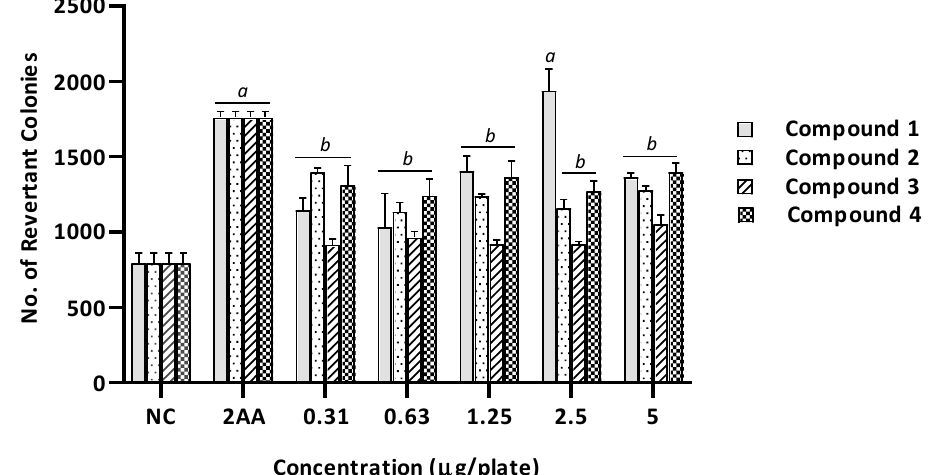
Figure 4. The number of revertant colonies of TA98 strain of Salmonella typhimurium treated with di ff erent concentration of benzimidazole derivatives (1–4) in the presence of metabolic activation system ( + S9). NC, Negative control (1% of DMSO in PBS); 2AA (2-aminoanthracene), Positive control (5 µ g / plate). Values were expressed as mean ± SEM of three independent experiments. a , significantly di ff erent ( p < 0.05) from the NC group; b , significantly di ff erent ( p < 0.05) from the positive control group